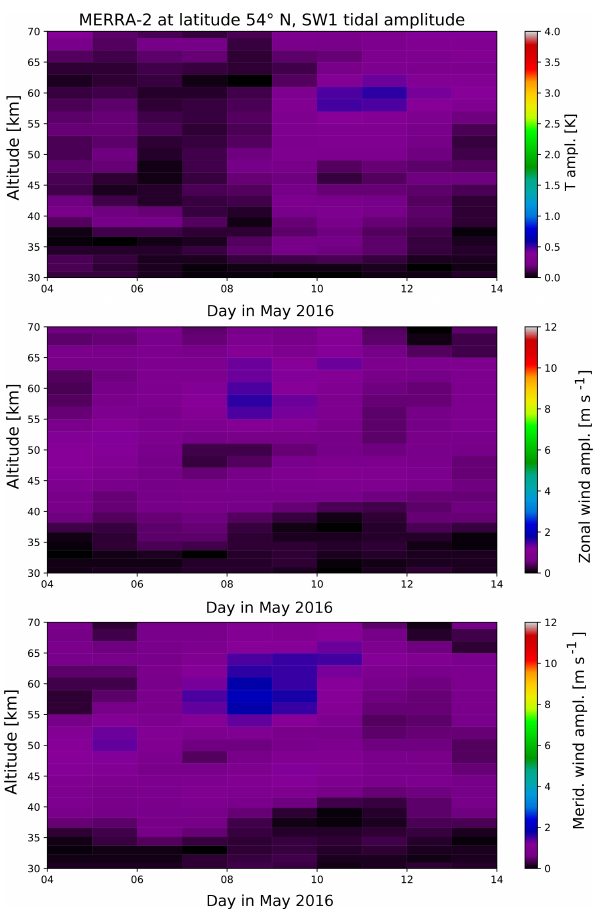
Figure A6. SW3 amplitude in temperature, zonal and meridional wind from global MERRA-2 fields at the latitude of 54 ◦